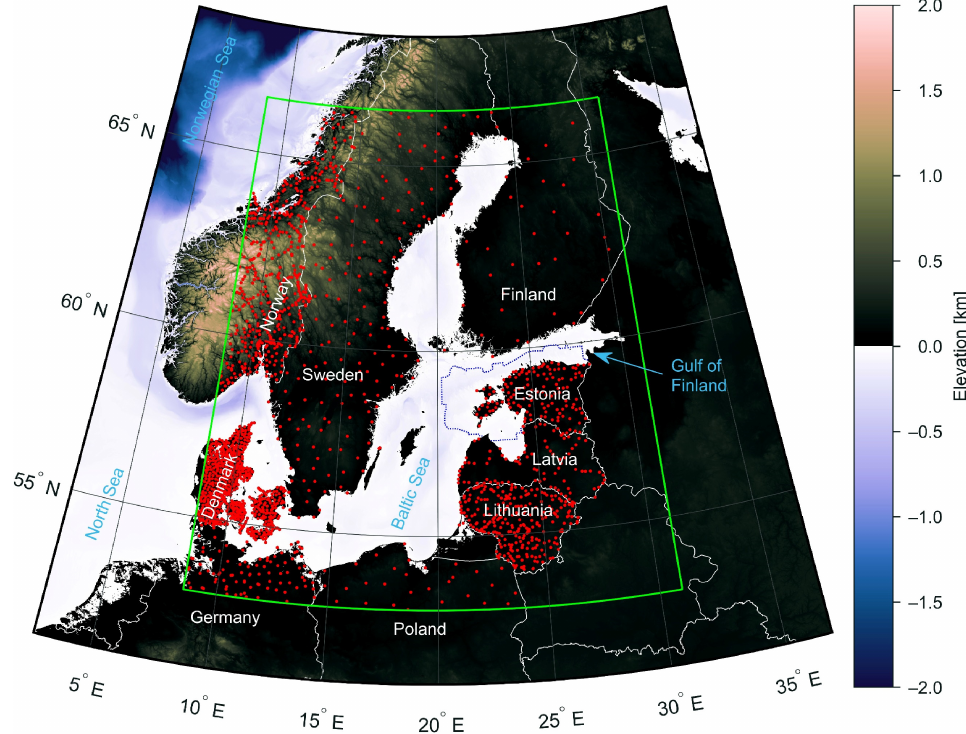
Figure 1. Terrain elevations and bathymetry. The dashed blue line surrounding Estonia shows the boundaries of the Estonian Maritime Administration obtained bathymetry data. Red dots are GNSS- leveling control point locations, and the green rectangle denotes the geoid modeling target area.